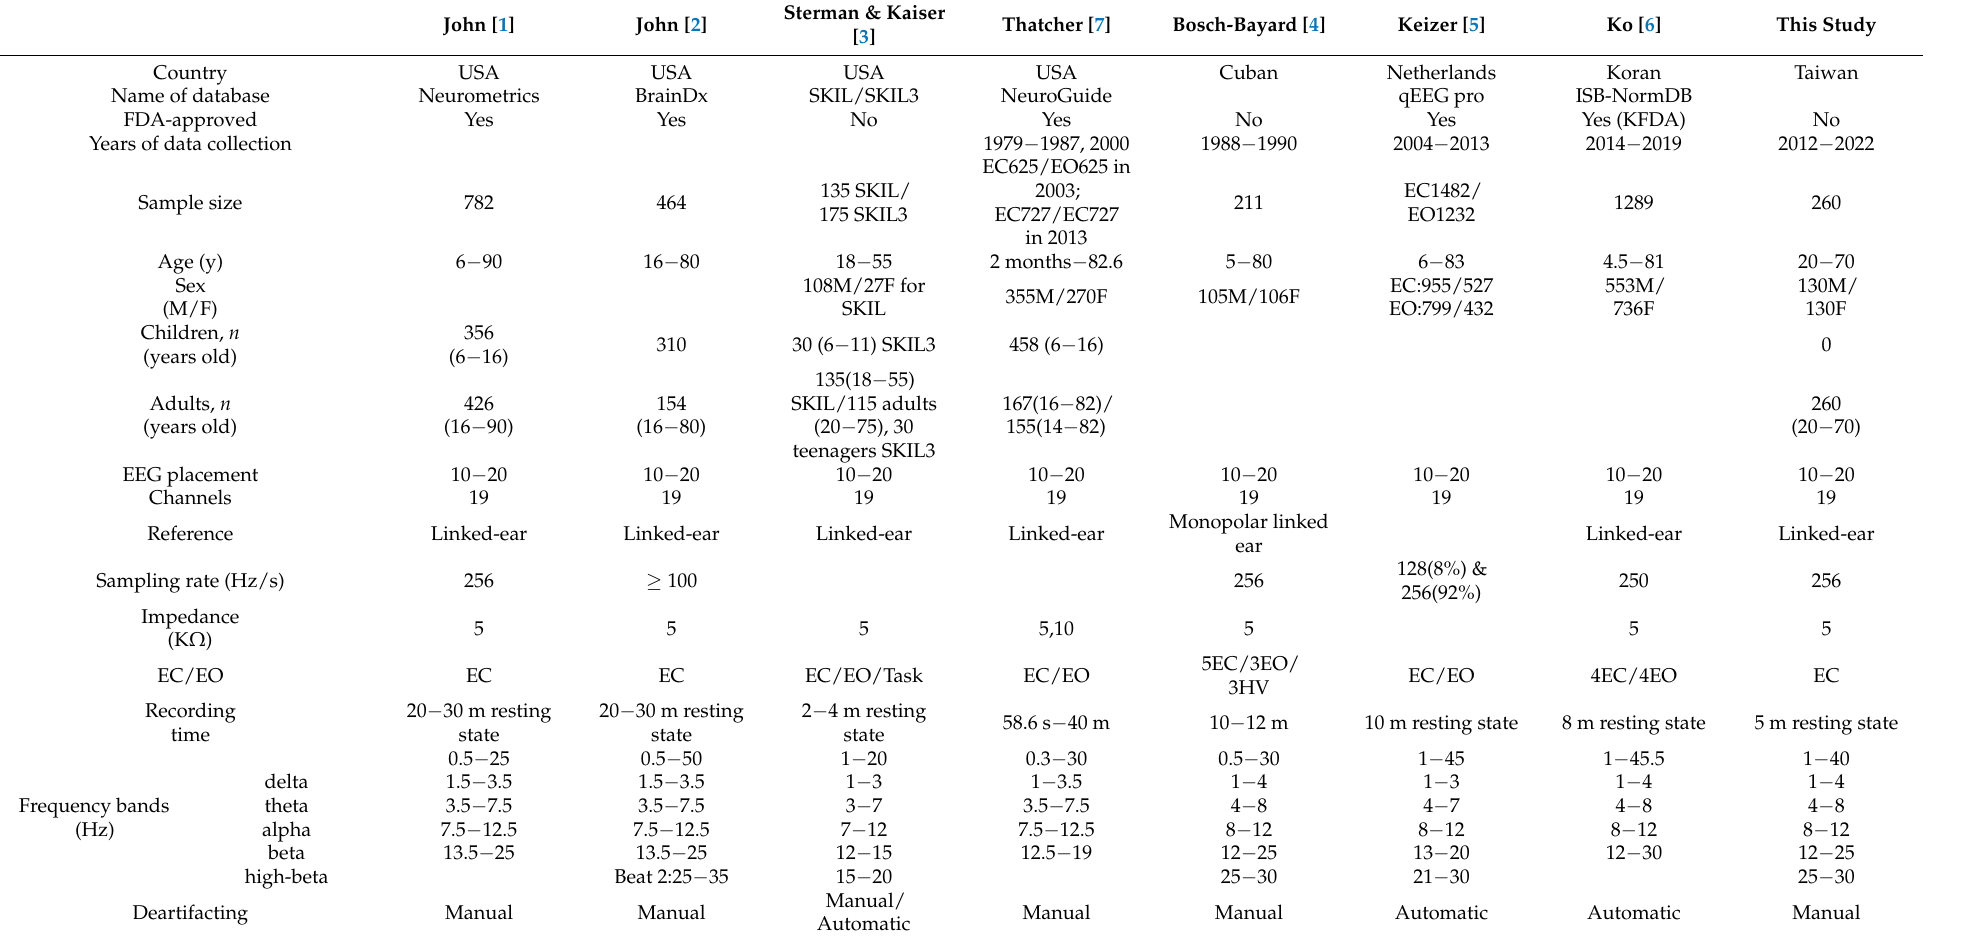
Table 1. The EEG normative